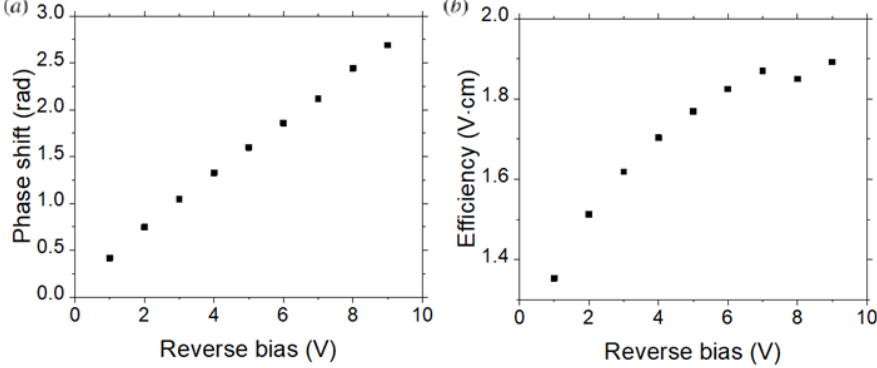
Figure 6. Measured DC performance of a 1.8 mm long Si depletion modulator. ( a ) Phase shift and ( b ) modulator efficiency.